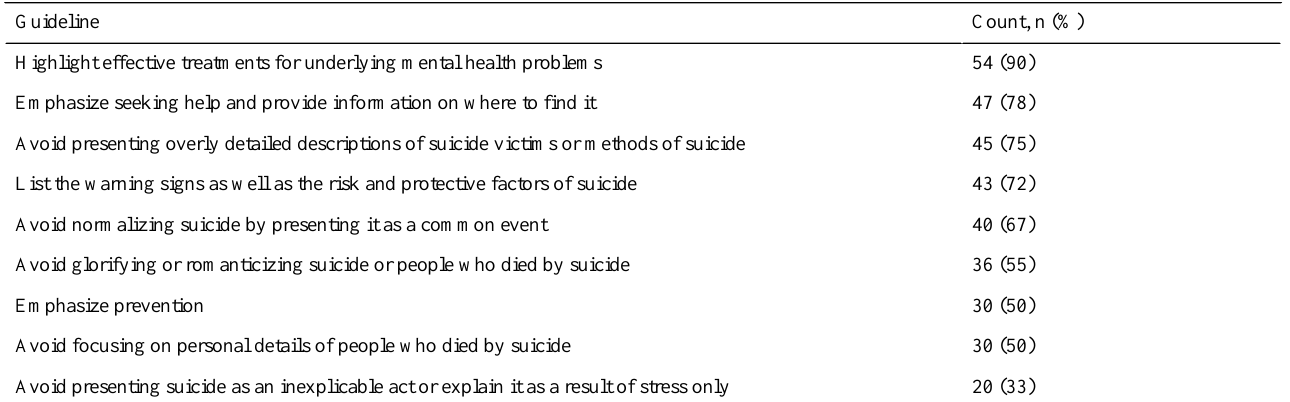
Table 4. Percentage of videos violating each Suicide Prevention Resource Center safe messaging